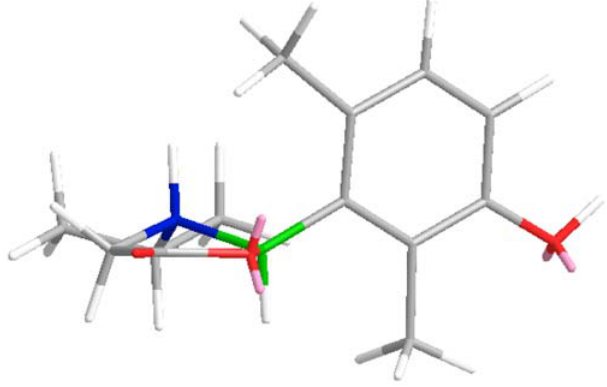
Blue: C-4 R ; Green: C-5 S .